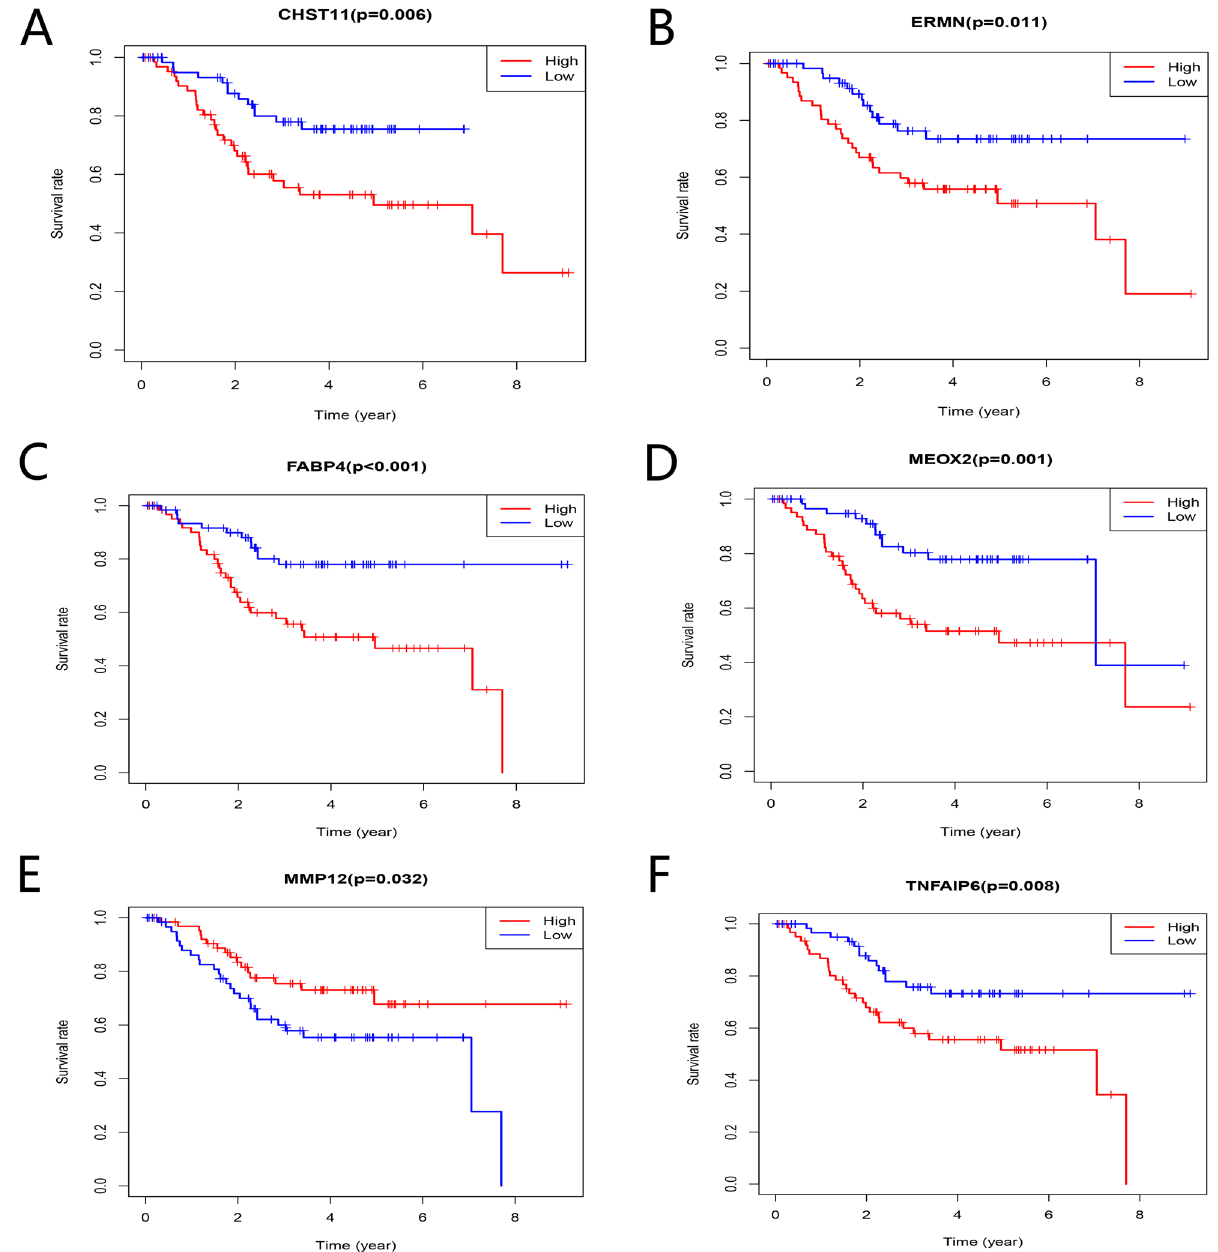
Figure 7. Validation of correlation of DEGs associated with prognosis extracted from TCGA database with overall survival in GSE161158 of GEO database. Six genes (MMP12, CHST11, ERMN, FABP4, MEOX2, and TNFAIP6) were verified to be related to prognosis. p <